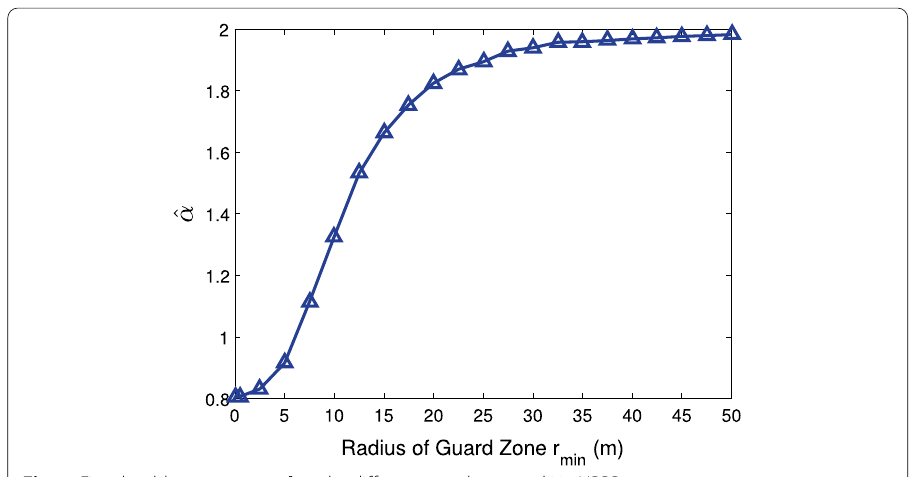
Fig. 4 Fitted stable parameter— ˆ α under different guard‑zone radii in